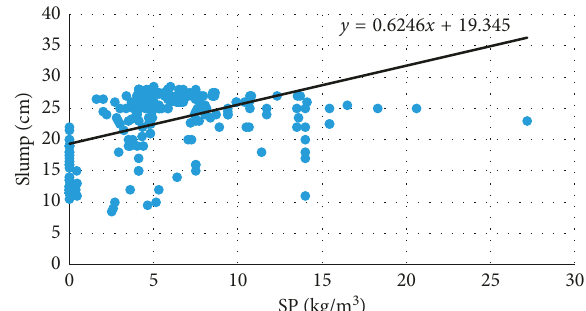
Figure 12: Distribution of slump and SP for the training samples of the SPNN.